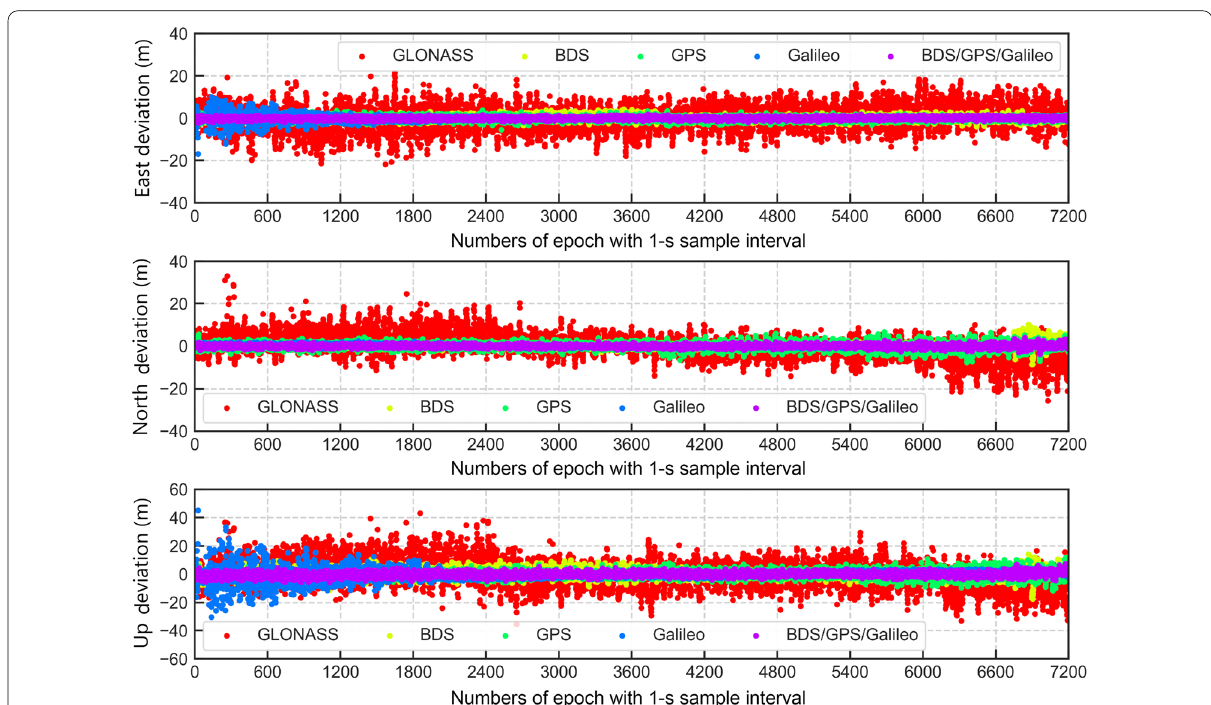
Fig. 17 Smartphone positioning deviation series in the east, north and up directions based on different systems